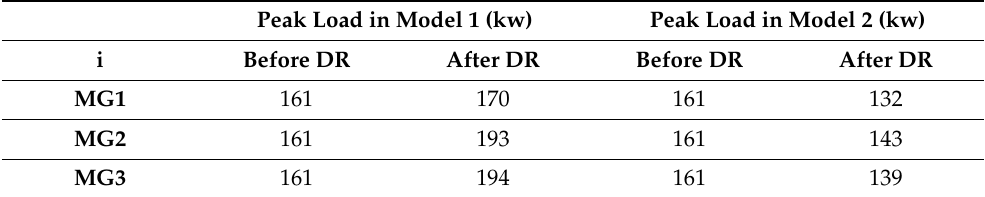
Table 2. Change in peak load in each microgrid before and after optimization.